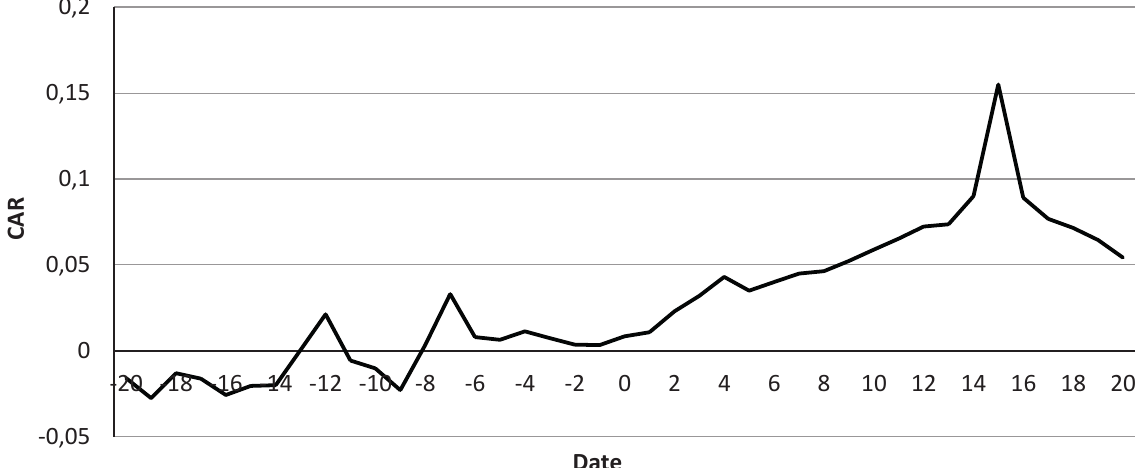
Figure 2. Average cumulative abnormal returns (with event window (-20, 20))